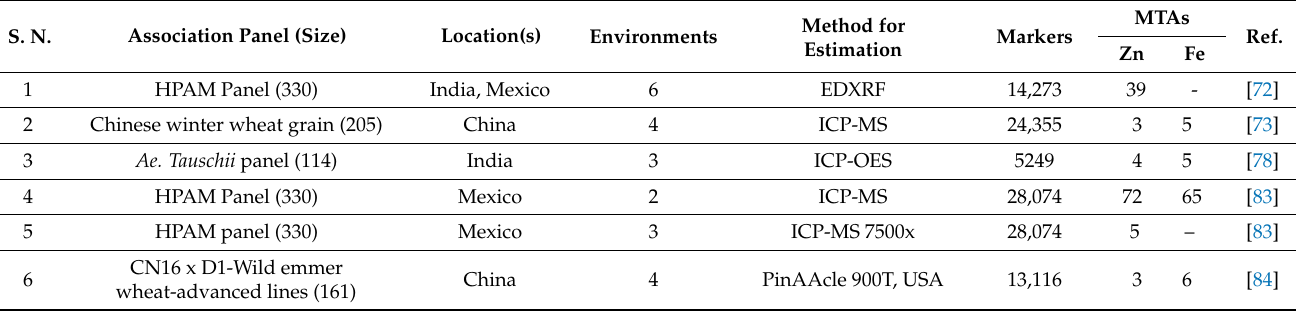
Table 3. Identified MTAs in Triticum aestivum L. and Ae. tauschii using